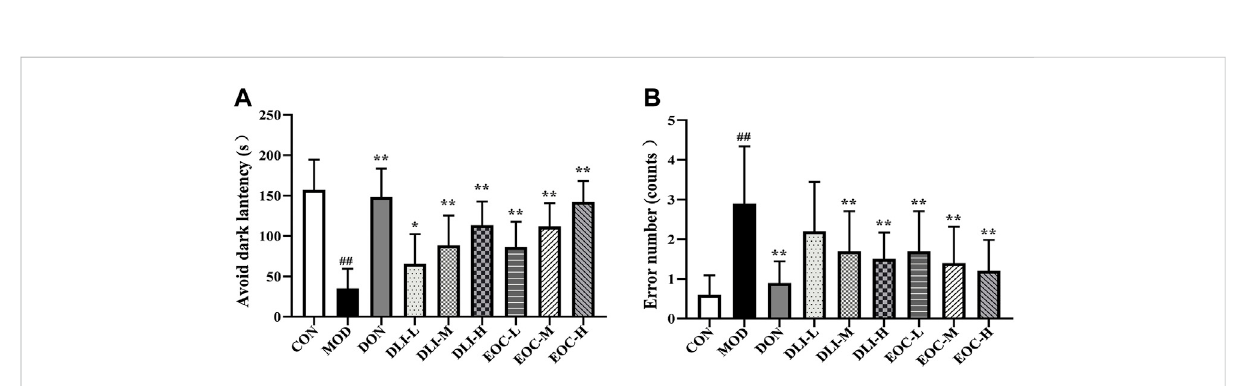
FIGURE 3 EffectofEOCandDLIonthestep-throughmazetestinmice( n =10). (A) Latencyto fi rstentryintothedarkroom. (B) Thenumberofentriesinto the dark room. # p < 0.05; ## p < 0.01 vs. the CON group; * p < 0.05, ** p < 0.01 vs. the MOD